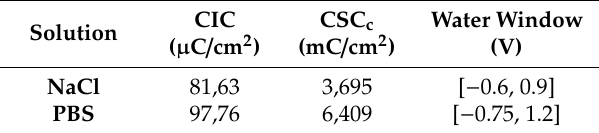
Figure 14. Impedance of the Pt cu ff electrode G in PBS and NaCl solutions. Table 5. Values of the cu ff electrode G in PBS and NaCl